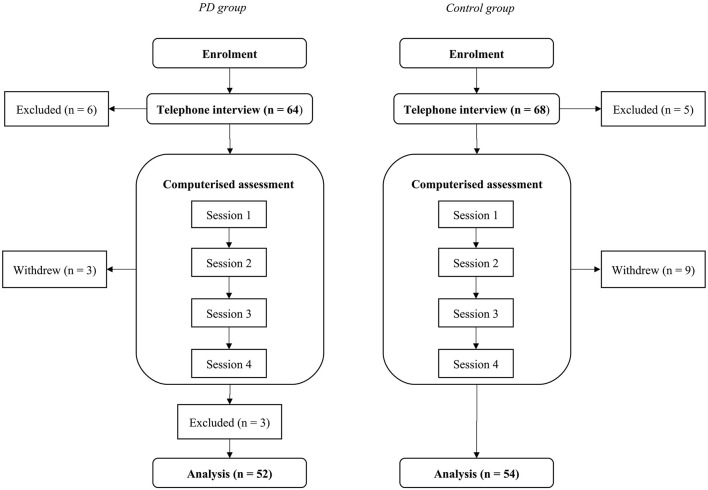
Chart for the study procedure. The Parkinson’s disease (PD) group is shown on the left and the control group on the right.